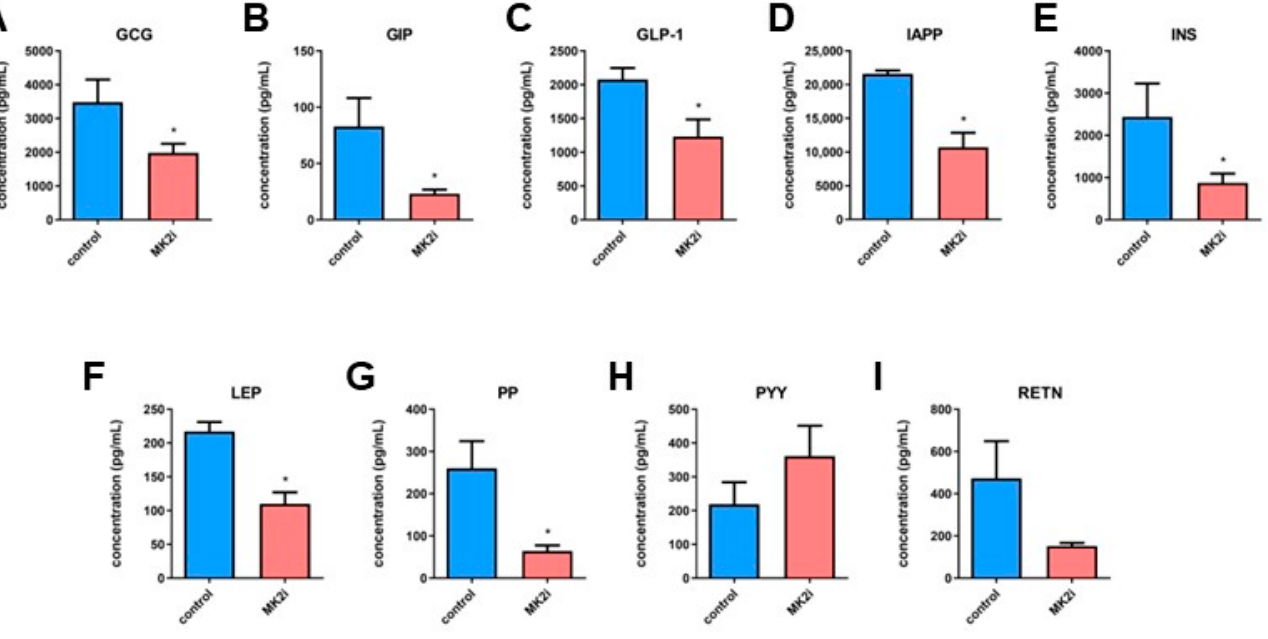
Figure 3. MK2 inhibition suppress production of metabolic factors in PNETs. Tumor supernatants were examined by multiplex array for the concentration of GCG ( A ), GIP ( B ), GLP-1 ( C ), IAPP ( D ), INS ( E ), LEP ( F ), PP ( G ), PYY ( H ) and RETN ( I ) from tumors obtained from RipTag2 mice treated with DMSO (control, blue) and MK2 inhibitor (MK2i, red). Data are presented as means ± SEM; * p < 0.05 vs. control; n = 6 in each group.